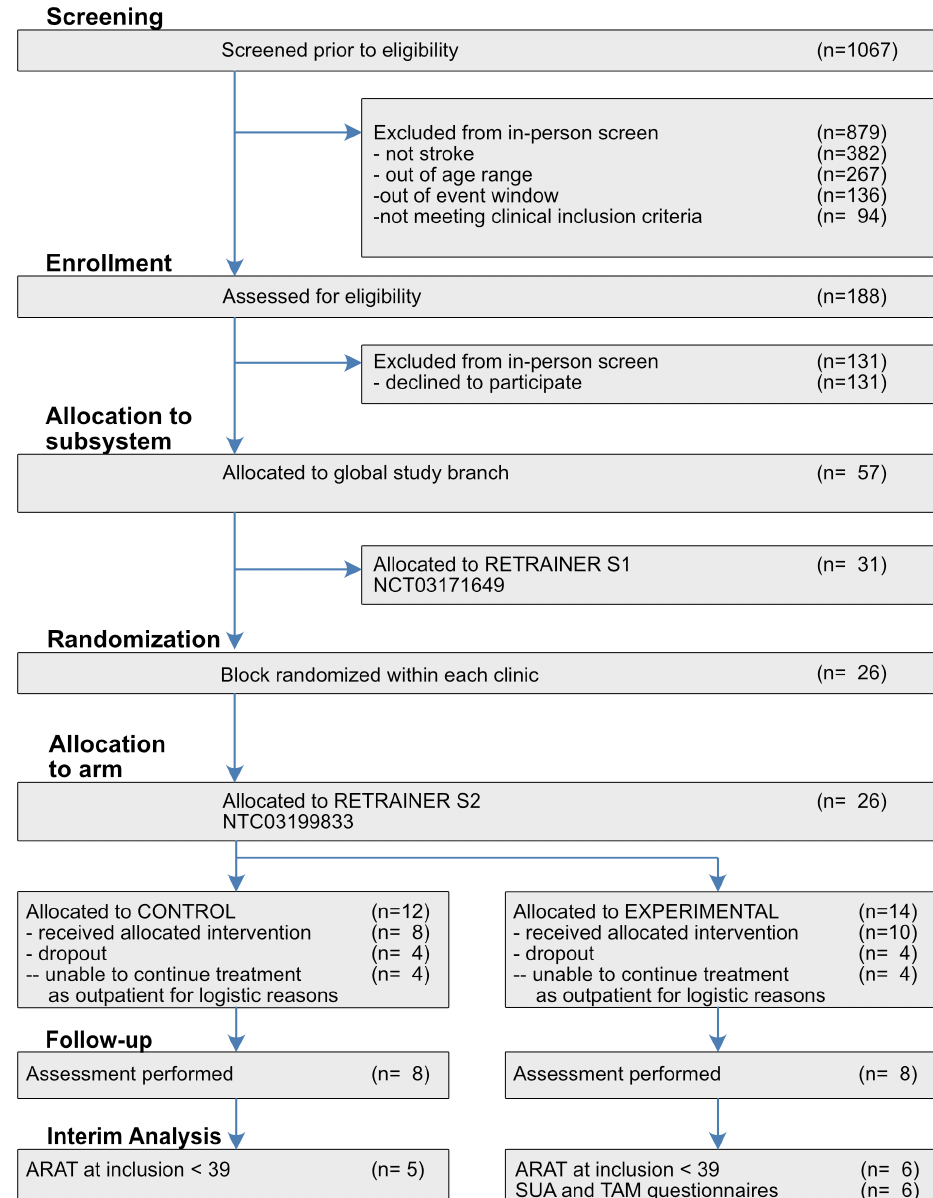
Figure 3. CONSORT diagram. Consolidated Standards of Reporting Trials diagram. Depiction of subject selection, group allocation, attrition, and data analysis. Abbreviations: S1, subsystem 1; S2, subsystem 2; CONTROL, S2 control group; EXPERIMENTAL, S2 experimental